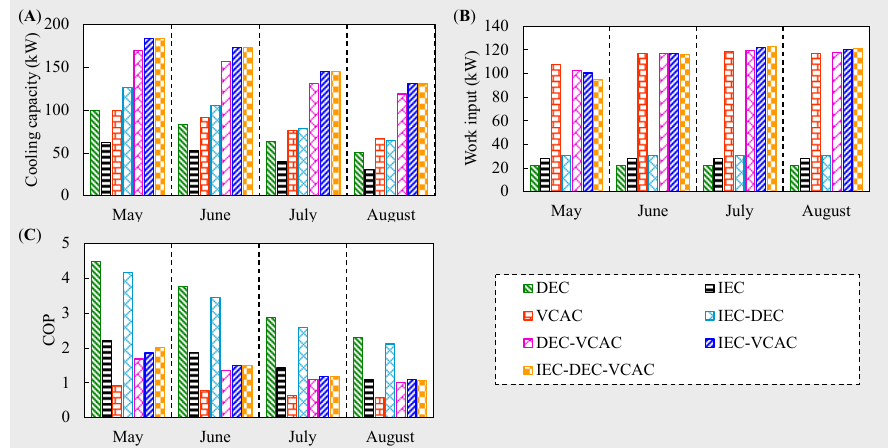
Figure 11. Variation in ( a ) Cooling capacity, ( b ) work input, and ( c ) COP of the seven AC configurations in summer.